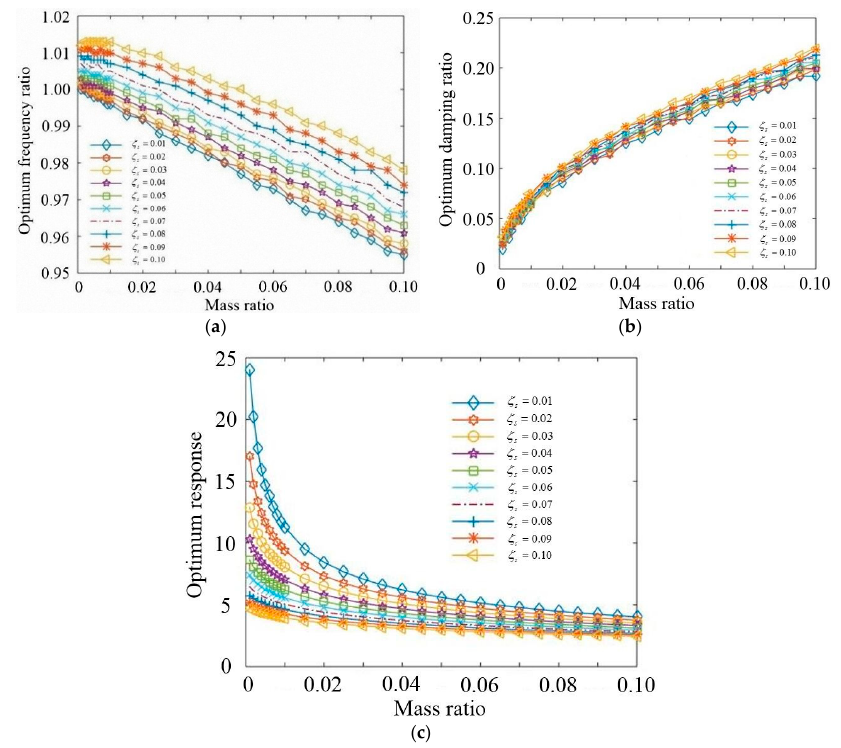
Figure 2. Comparison of the optimum parameters of TMD systems based on artificial fish swarm algorithm (AFSA) for different mass ratios and damping ratios of the primary structure under external excitations. ( a ) Comparison of optimum frequency ratio; ( b ) Comparison of optimum damping ratio; ( c ) Comparison of optimum response.